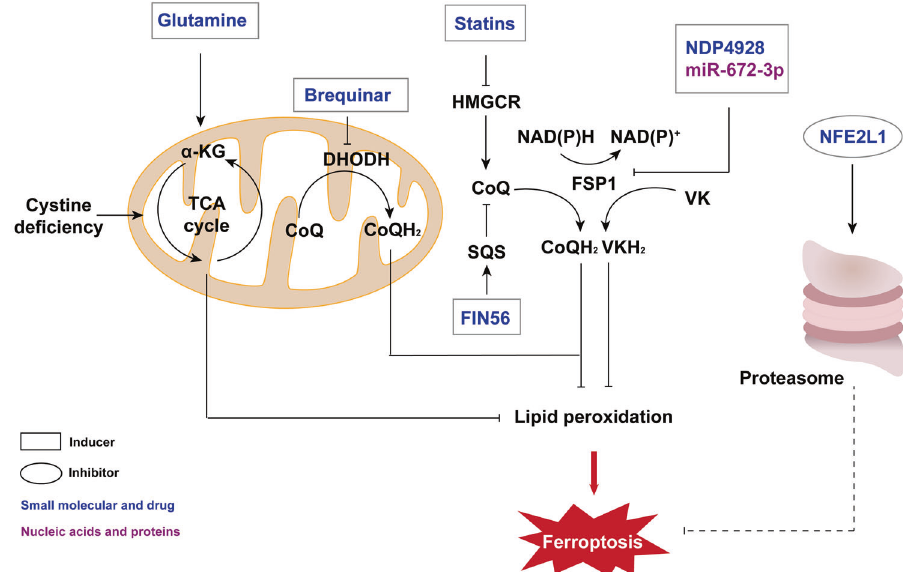
Fig. 4 FSP1/CoQ and other metabolism pathways involved in ferroptosis. FSP1 can catalyze the transition from VK to VKH 2 and CoQ to CoQH 2 also catalyzed by DHODH to affect the process of ferroptosis. Thus, regulators targeting these two proteins such as miR-672-3p and brequinar can regulate ferroptosis. In addition, TCA cycle promoted by glutaminolysis can contribute to lipid peroxidation in the case of cystine de fi ciency to inhibit ferroptosis. Moreover, the proteasome regulates ferroptosis in a temporarily unde fi ned manner. α -KG α - ketoglutarate dehydrogenase complex, TCA cycle tricarboxylic acid cycle, DHODH dihydroorotate dehydrogenase, CoQ coenzyme Q, HMGCR